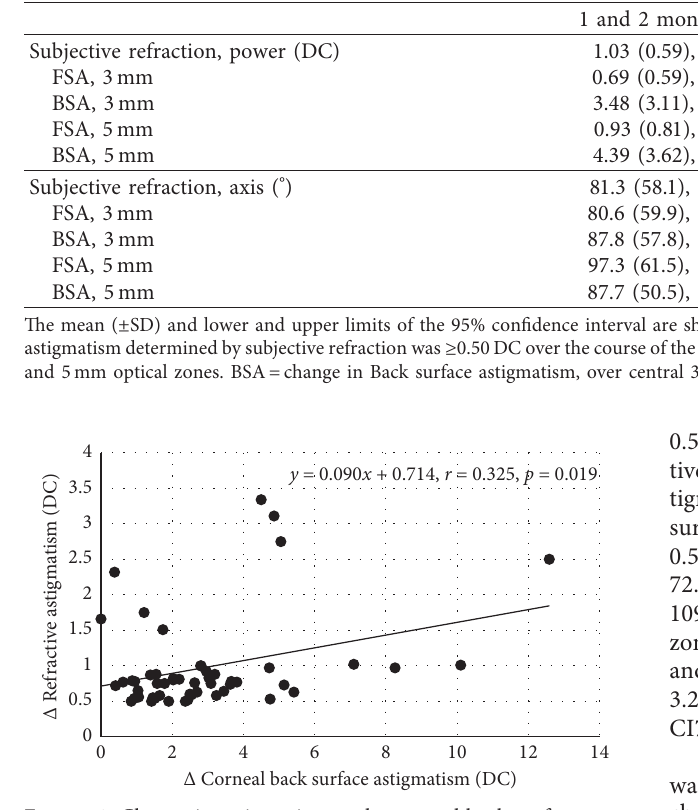
Figure 1: Change in astigmatism at the corneal back surface over the central 3mm zone ( x axis) and the corresponding change in residual refractive astigmatic error determined by autorefrac- tometry ( y axis) between 1 and 2 months postoperatively. All units are in